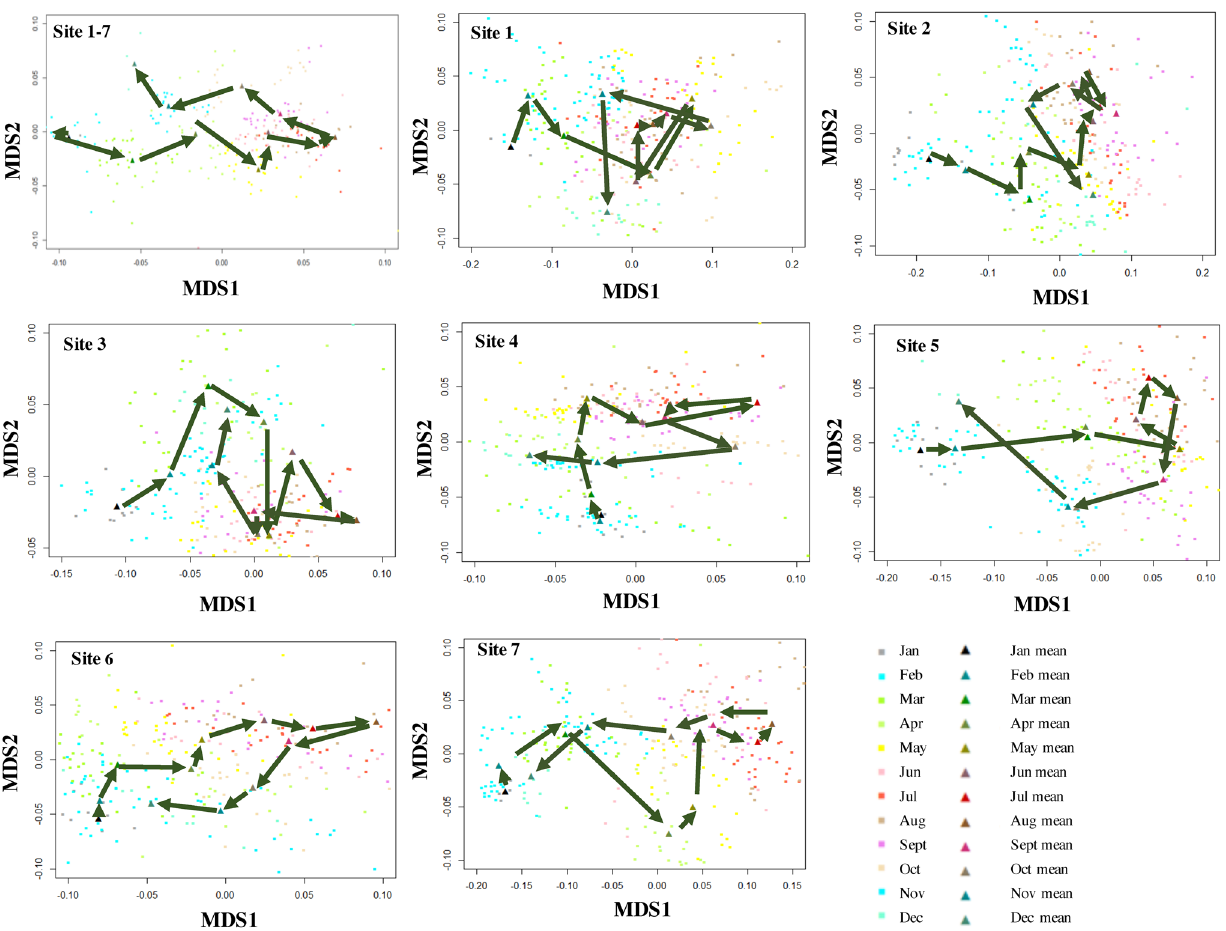
Figure 1. Non-Metric Multidimensional Scaling (NMDS) of samples from seven on-line monitoring stations. Samples from January to December were indicated by solid circles in different colors, with the solid triangles representing the mean values of different